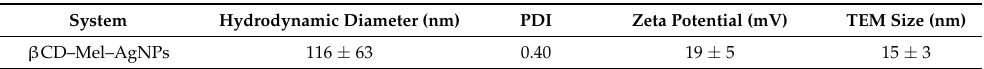
Table 2. Hydrodynamic diameter, polydispersity index (PDI), zeta potential, and TEM size of β CD–Mel–AgNPs colloidal